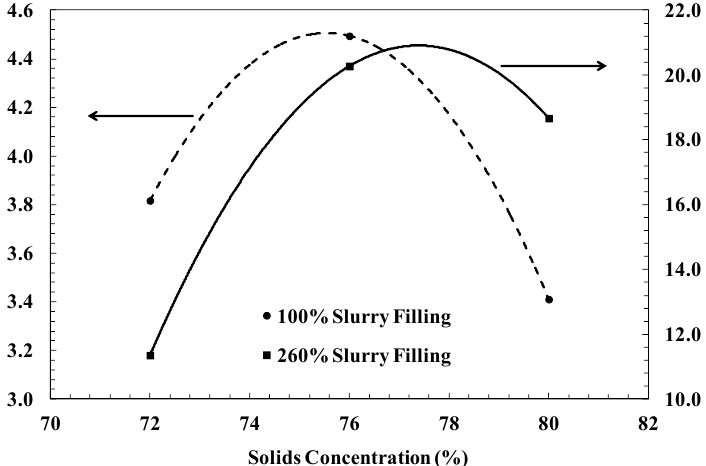
Figure 8. Relationship between solids concentration and ζ 1 (y-axes) from batch tests carried out at different slurry fillings.